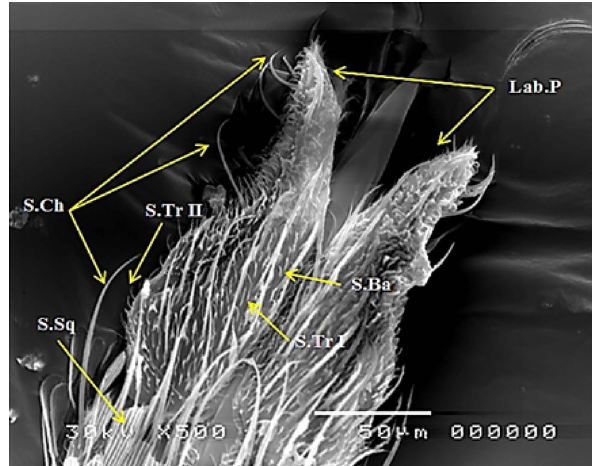
Figure 4. SEM photography of control, Culex pipiens female labial palps (500×) showing three size of smooth sensilla chateica (S.Ch) at the tip of labellum, sensilla trichodea (S.Tr I& S.Tr II), sensilla basiconica (S.Ba) and sensilla squamiformia